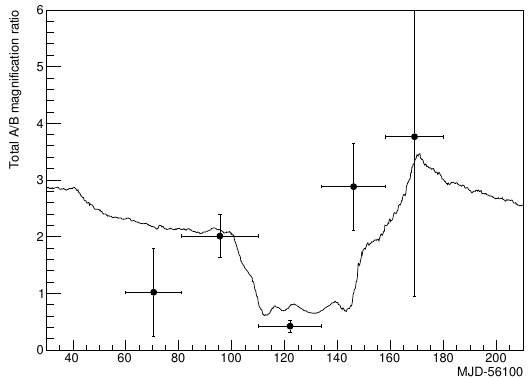
Figure 2. Changes of the total magnification ratio of the leading to trailing component seen in Fermi -LAT data during the 2012 high state of QSO B0218+357 (black circles, [4]). The black solid line shows the changes of the magnification ratio obtained along one of the simulated paths of the trailing image through a GMC with a mass of 2 × 10 5 M (cid:12) . Strong lensing with a magnification ratio of 3.6, with proper motion of 0.2 mas/year and size of the gamma-ray emission region of 0.01pc are assumed. Figure reproduced from